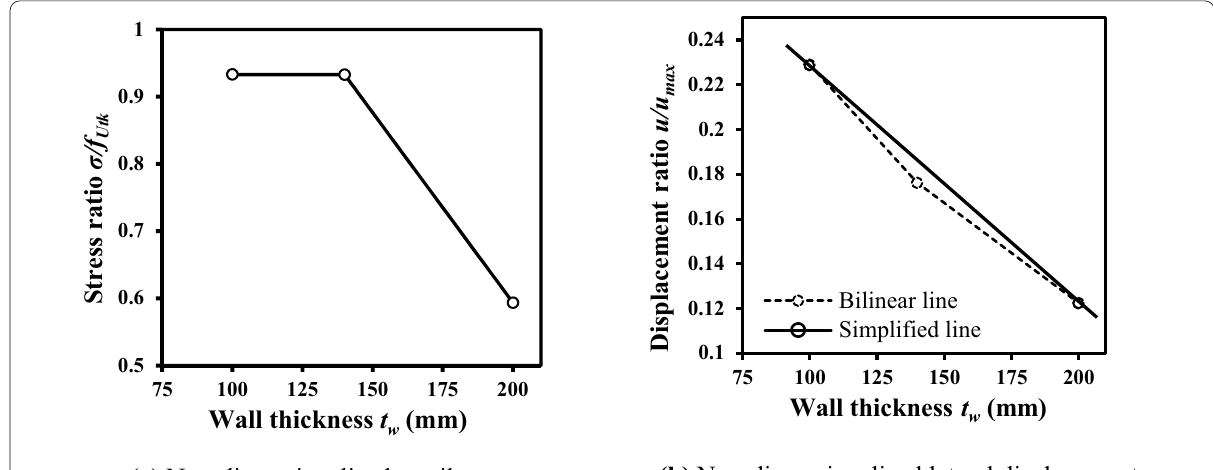
Fig. 7 Regression curves of the tensile stress and lateral displacement according to wall